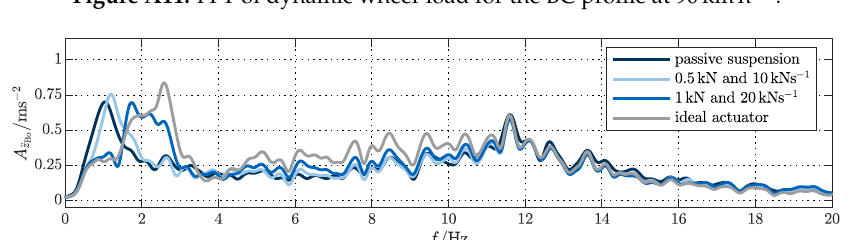
Figure A11. FFT of dynamic wheel-load for the BC profile at 90kmh − 1 .